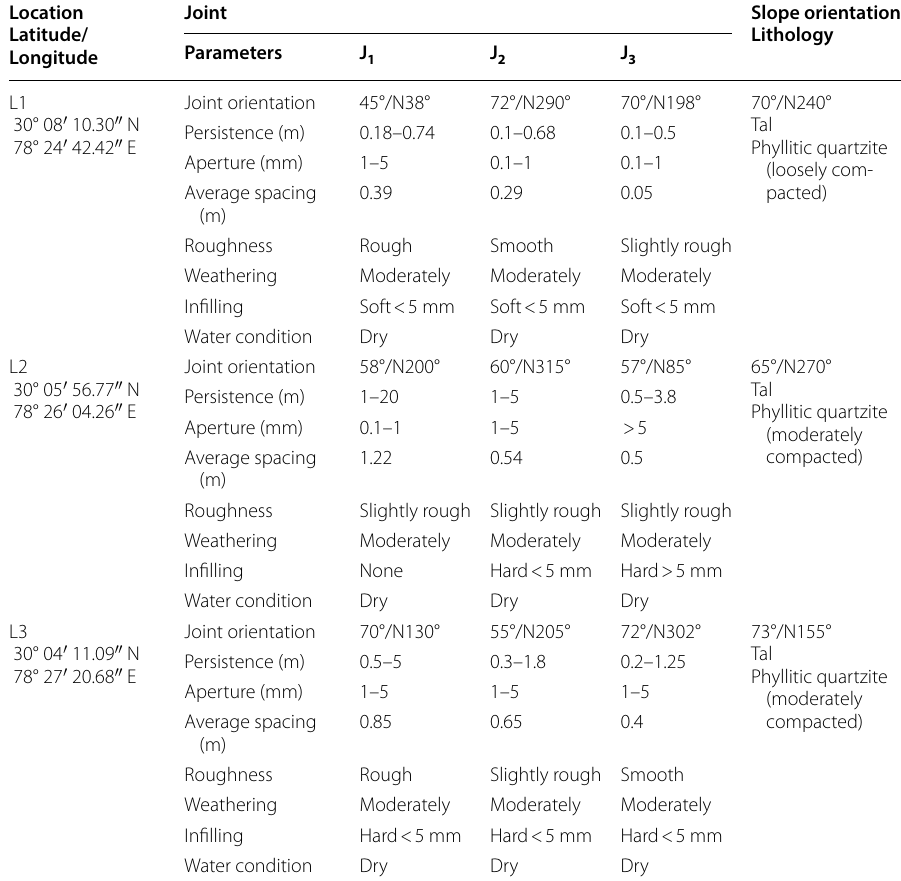
Table 1 Attributes of discontinuities and various geotechnical parameter with their coordinates Location